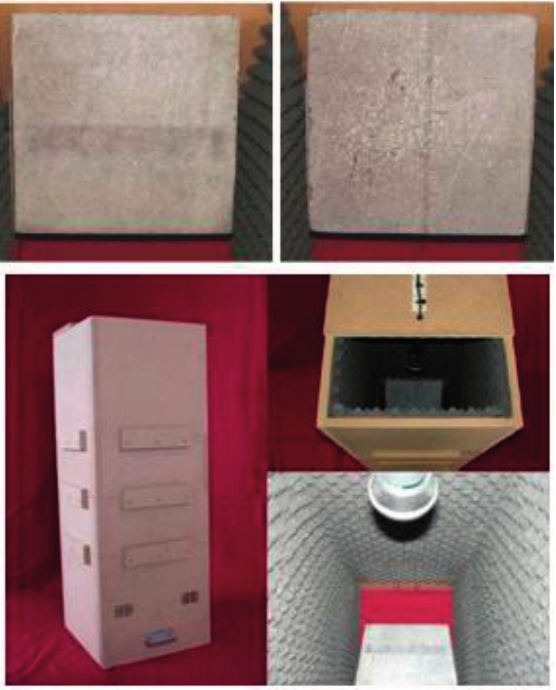
Figure 1. Stone plate for impact test and impact acoustic emission (AE) acquisition chamber. The stone plate was set near to the bottom of the chamber at an angle of 30° downward. Also, the height for scrap dropping was set at 750